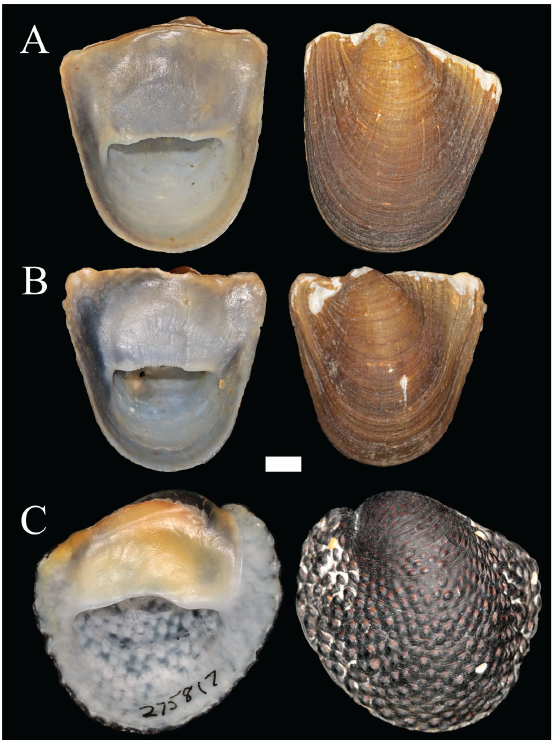
Figure 2. Specimens of Hawaiian Neritidae in the Malacology Collection of the Bernice Pauahi Bishop Museum. ( A ) Neripteron cariosum (Wood, 1828) BPBM288518, ( B ) Neripteron vespertinum (Sowerby, 1849) BPBM288519, and ( C ) Neritona granosa (Sowerby, 1825) BPBM275817. Scale bar = 5